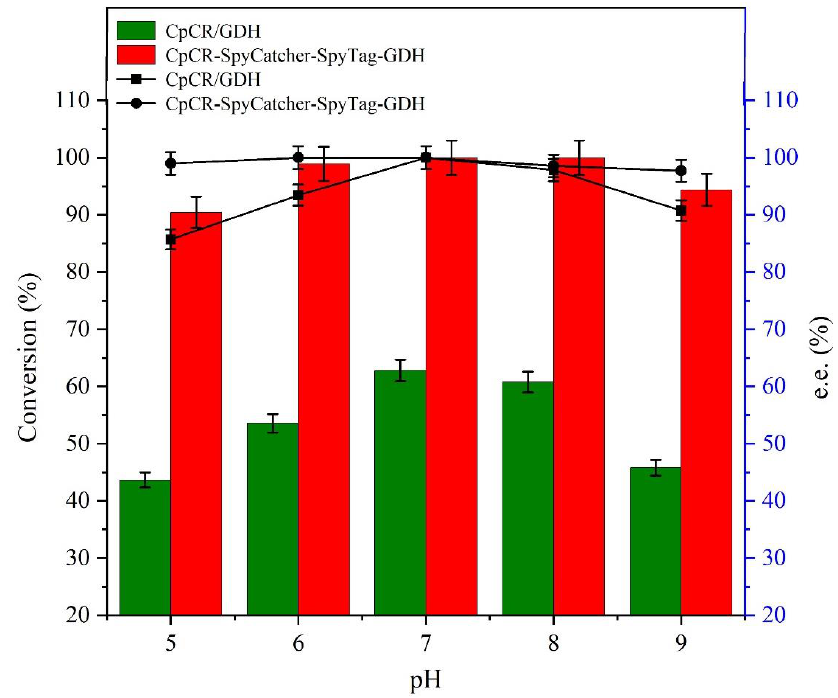
Figure 12. Effect of pH on CpCR-SpyCatcher-SpyTag-GDH and free enzymes.